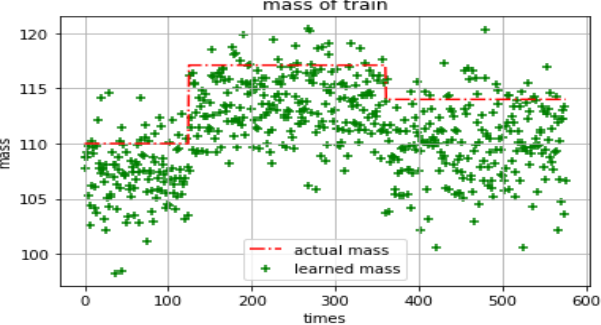
Figure 9. Train mass learning results.